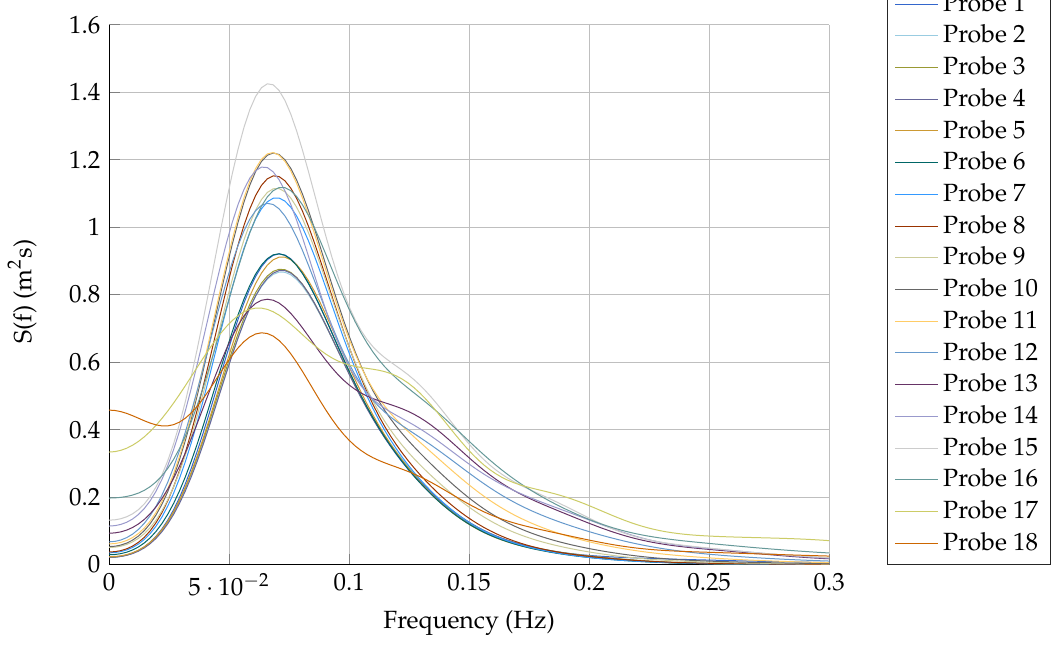
Figure 12. Observed spectra for the 9:00 p.m. hourly period for each probe along the flume.